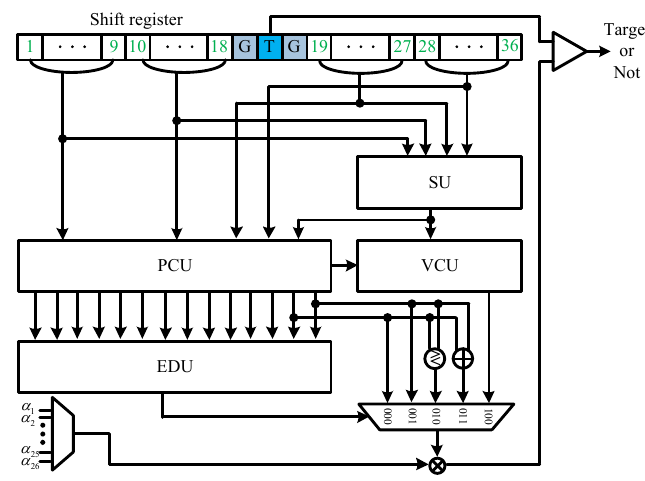
Figure 10. Hardware architecture of proposed CFAR